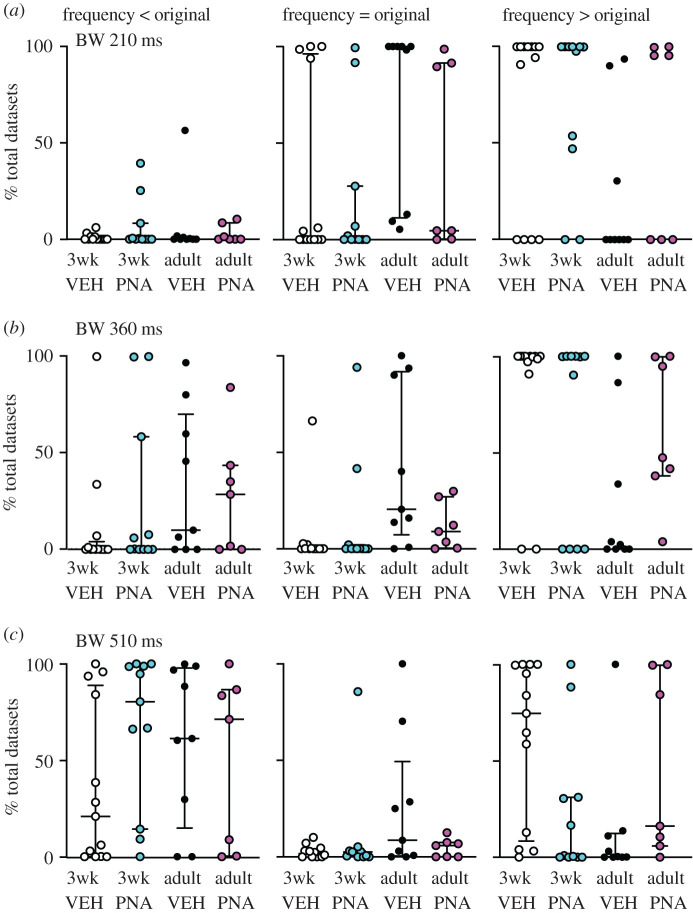
Burst frequency is lower in GnRH neurons in the physiologic range of burst windows (BW). Each dot shows the percentage of total datasets from an individual cell with a burst frequency less than (left), equal to (centre) or greater than (right) the original data's value for burst windows of (a) 210 ms, (b) 360 ms and (c) 510 ms. Graphs show individual values, median and interquartile range.